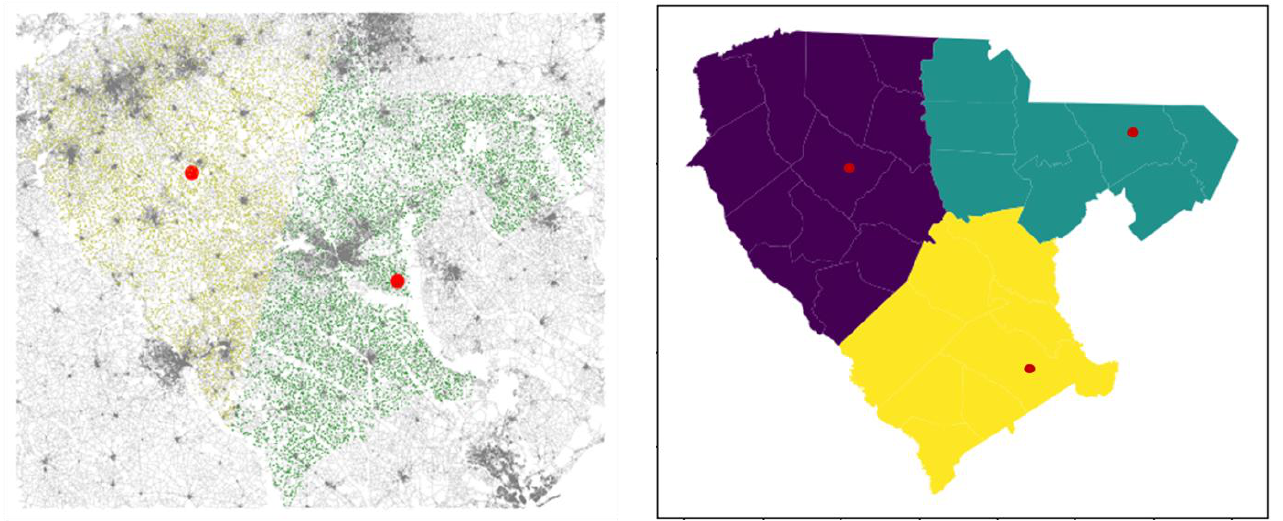
Figure 8. Candidate depot locations using K-means clustering with two field clusters ( left ) and using clustering coefficient with three field clusters ( right ). Red dots represent the locations of depots.